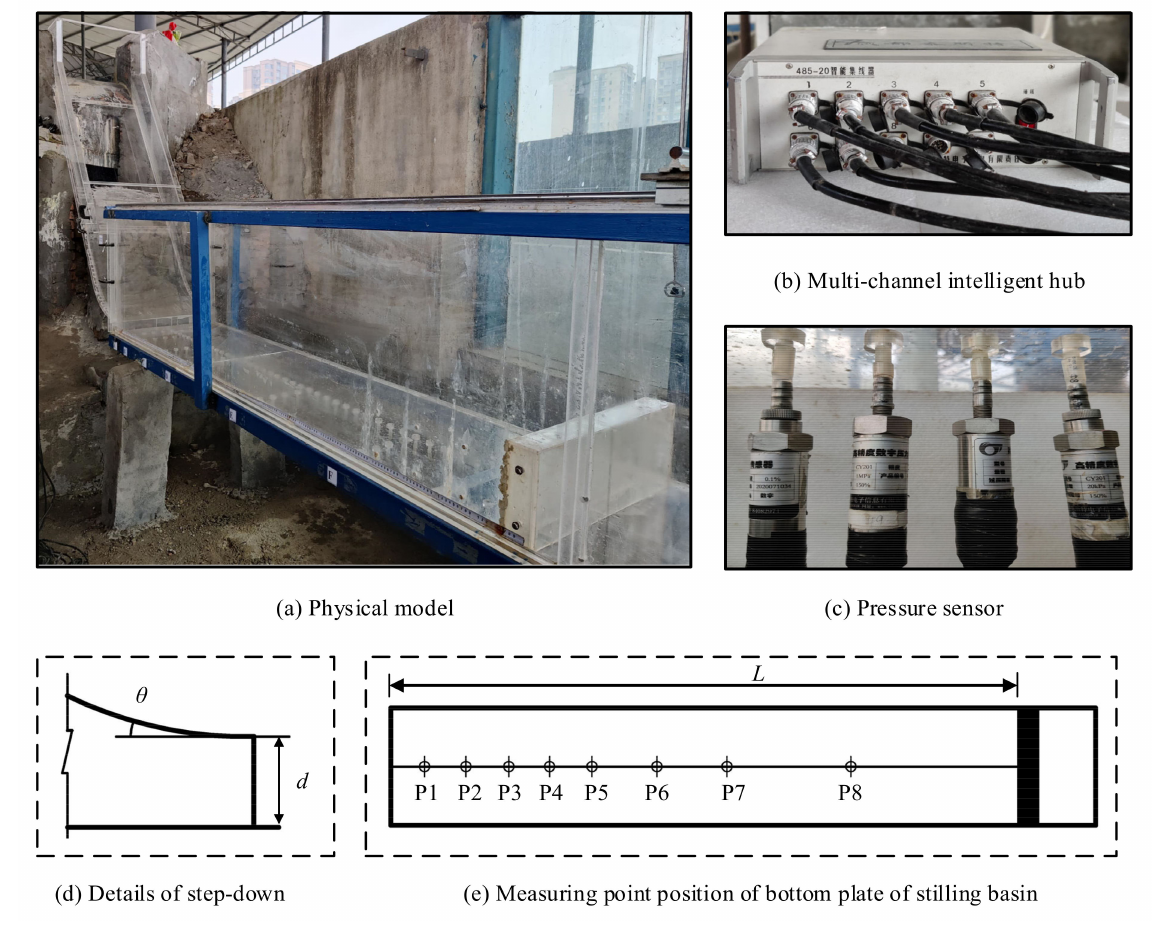
Figure 2. Experiment setup.